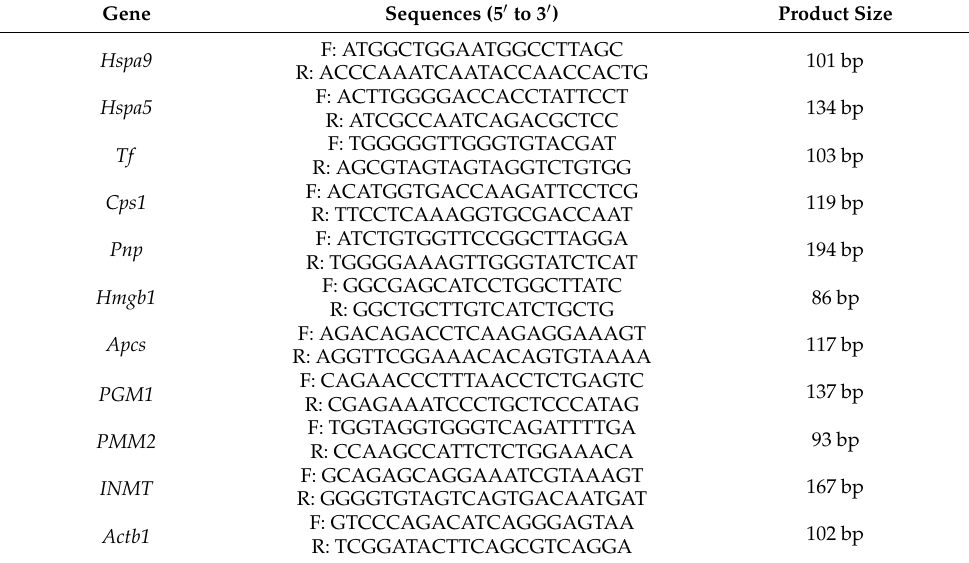
Table 1. Primers used for